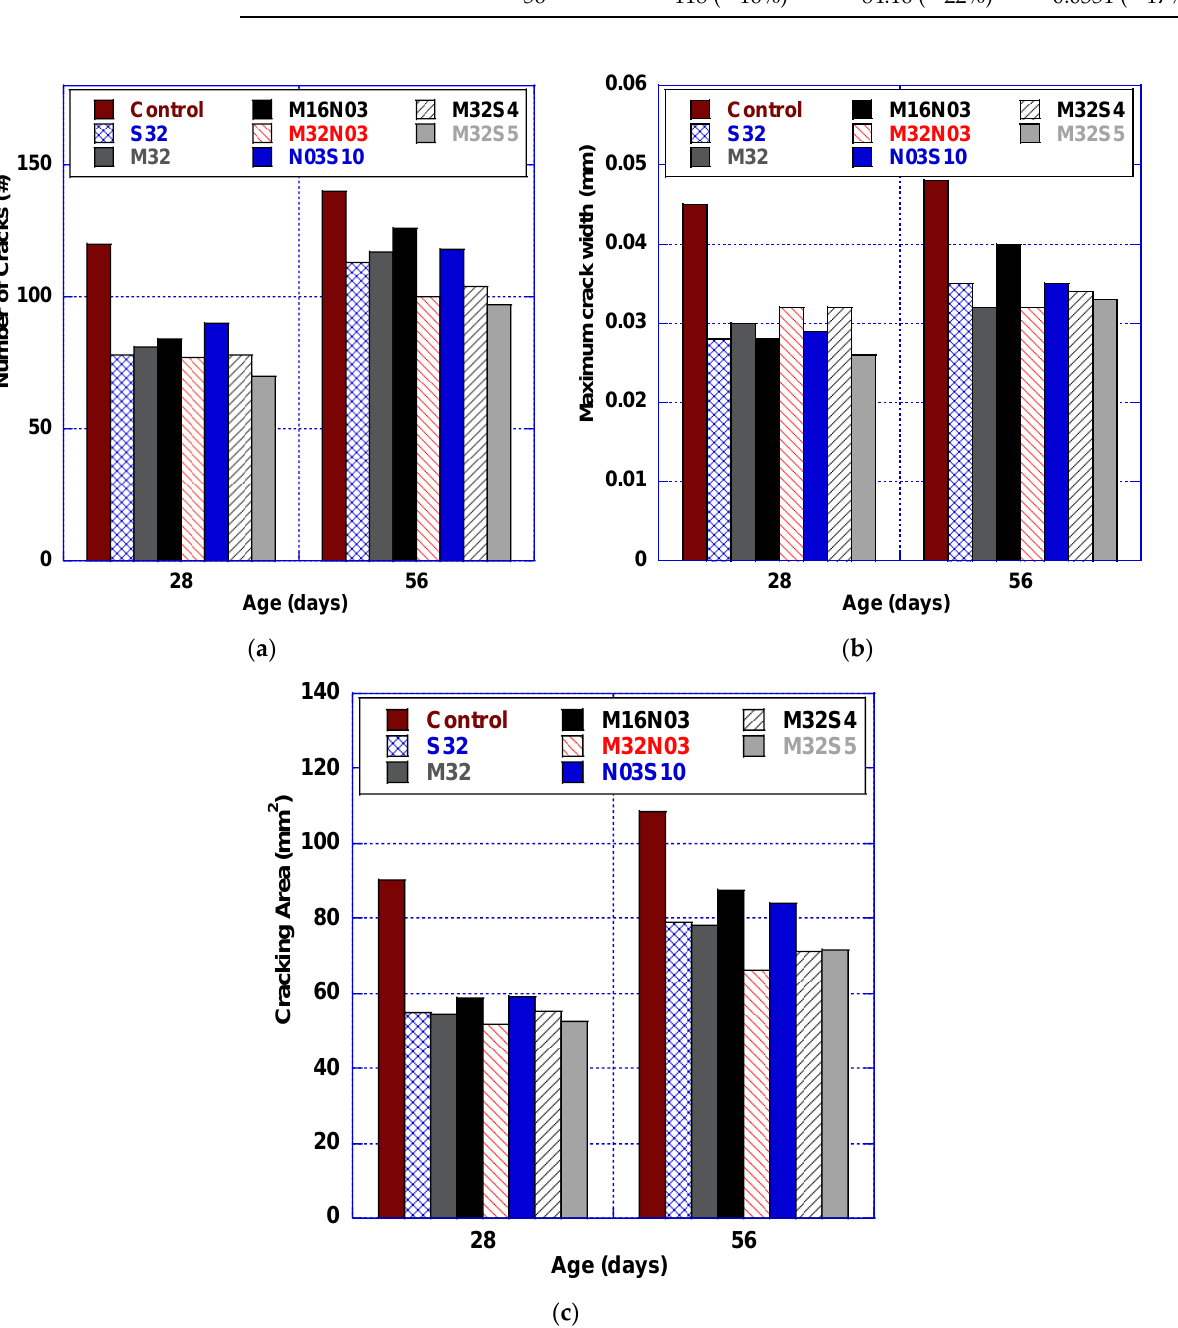
Figure 7. Cracking performance results: ( a ) number of cracks, ( b ) crack width, and ( c ) cracking area.